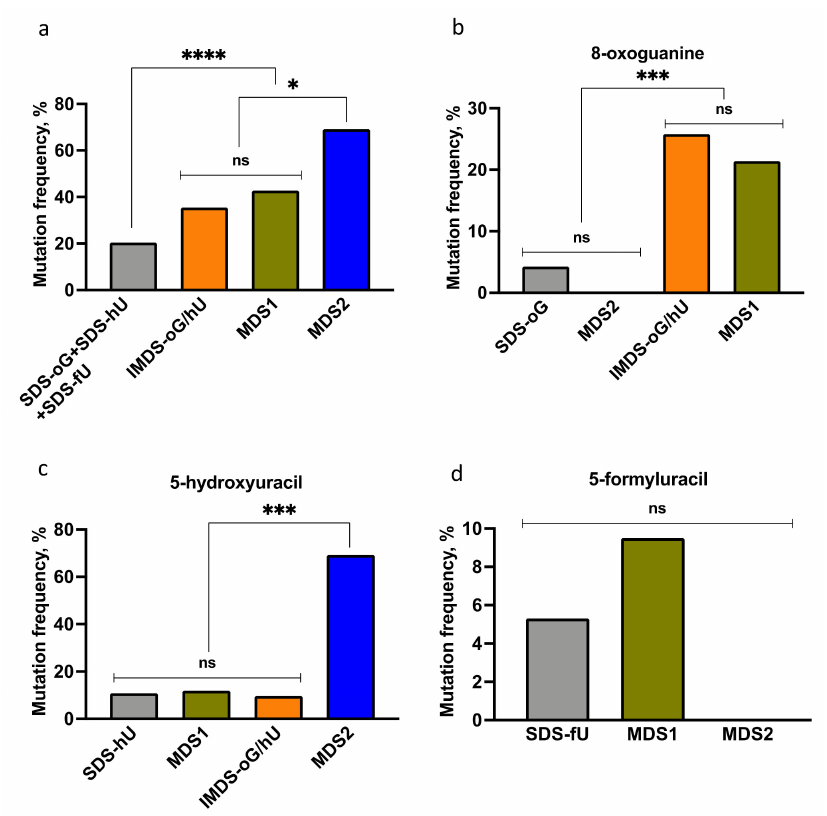
Figure 3. Mutation frequencies at complex MDS, as compared to singly damaged sites, in the WT yeast strain. ( a ) Total mutation frequencies at IMDS-oG/hU, MDS1, and MDS2 in comparison with the sum of mutation frequencies at singly damaged sites (sum of SDS vs. IMDS-oG/hU, MDS1, or MDS2, p < 10 − 4 ; IMDS-oG/hU vs. MDS1, p = 0.53; IMDS-oG/hU vs. MDS2, p = 0.017; MDS1 vs. MDS2, p = 0.025). ( b ) Targeted mutation frequencies at 8-oxoguanine (SDS-oG vs. IMDS-oG/hU, p = 0.0016; SDS-oG vs. MDS1, p = 0.0004). ( c ) Targeted mutation frequencies at 5-hydroxyuracil (SDS- hU vs. MDS2, p < 10 − 4 ). ( d ). Targeted mutation frequencies at 5-formyluracil. Statistical analysis was performed using Fisher’s exact test. p -values abbreviated as ****: p < 10 − 4 ; ***: 10 − 4 < p < 10 − 3 ; *: 10 − 2 < p < 0.05; ns: non-significant ( p ≥